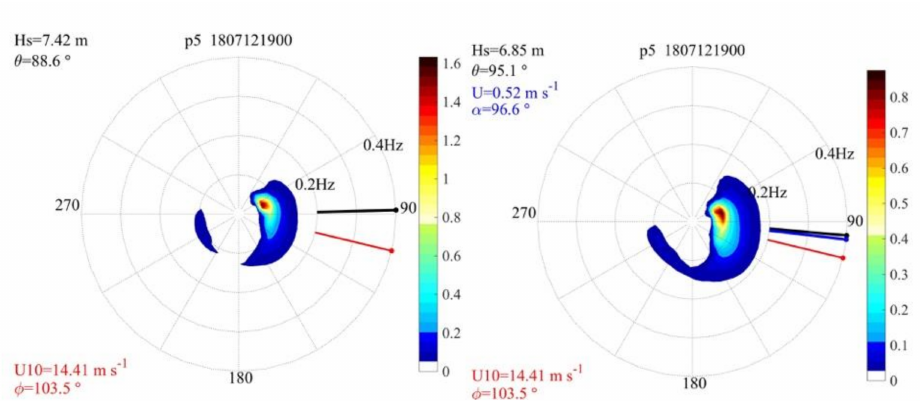
Figure 12. SWAN wave spectra at P5 (25 ◦ E, 38.36 ◦ S) for the 12 July 2018 at 19 UTC, from the simulation considering only waves ( left ) and considering waves and currents ( right ). Symbols: ϕ (wind direction), θ (wave direction), α (current direction), U (Current velocity). The arrowhead (circle) points to where the waves and currents propagate (oceanographic